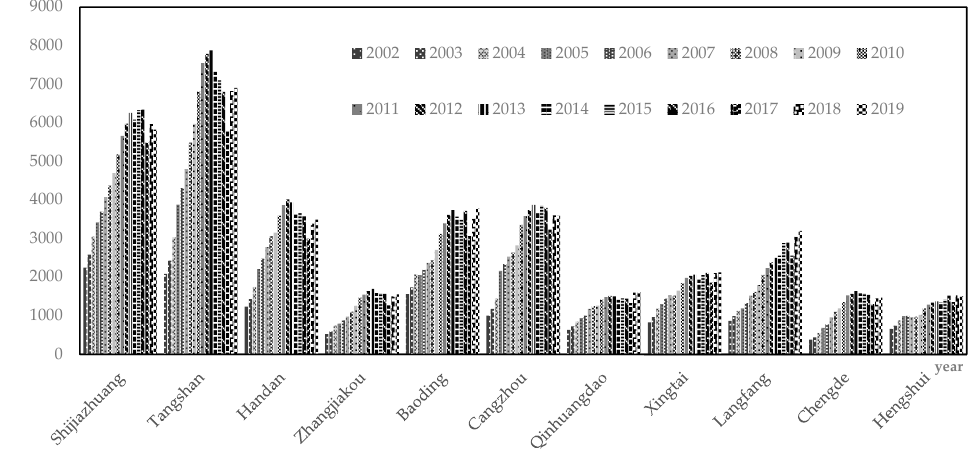
Figure 1. Changes in carbon emissions from UCL in Beijing, Tianjin and Hebei from 2002 to 2019.